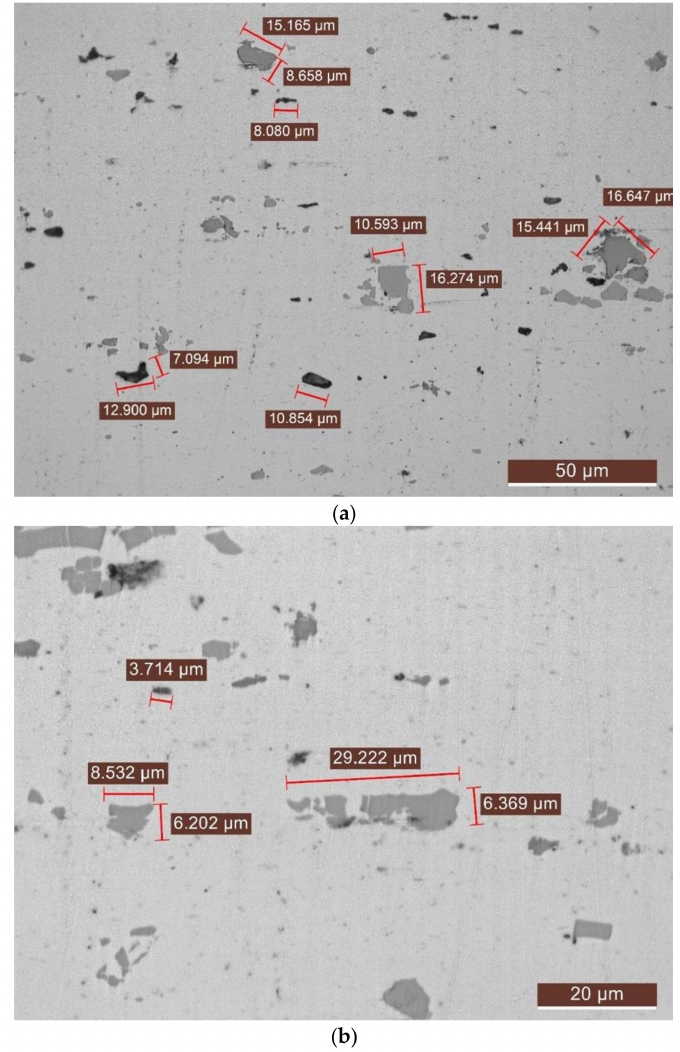
Figure 1. Optical micrography of AA5083-H111 specimens, with a magnification of ( a ) × 500 and ( b ) × 1000.